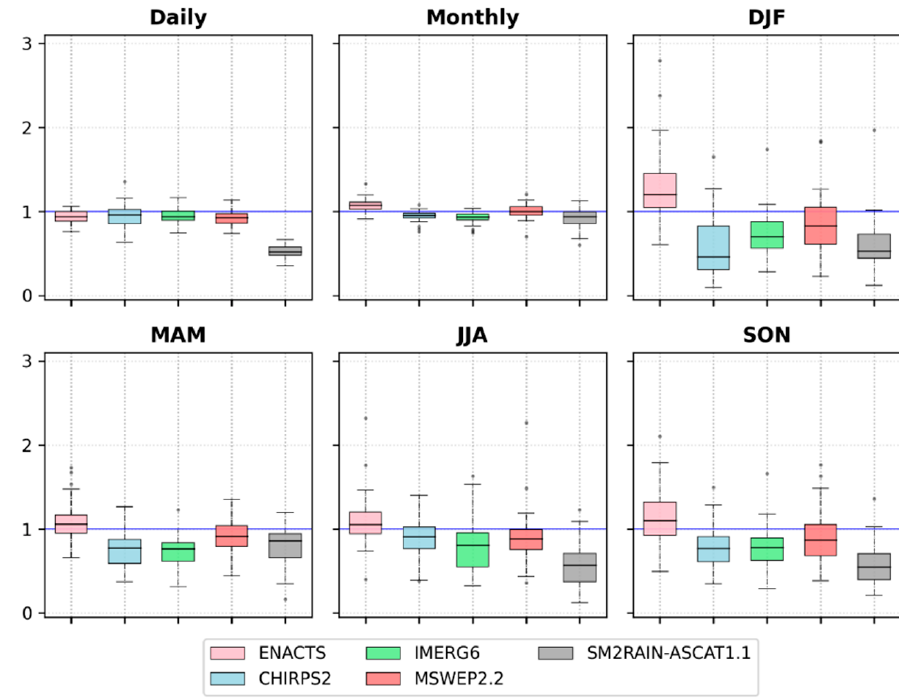
Figure 7. Variability ratio ( γ ) between different precipitation datasets and gauge observations on different temporal scales. The horizontal blue line indicates the optimum value for γ .